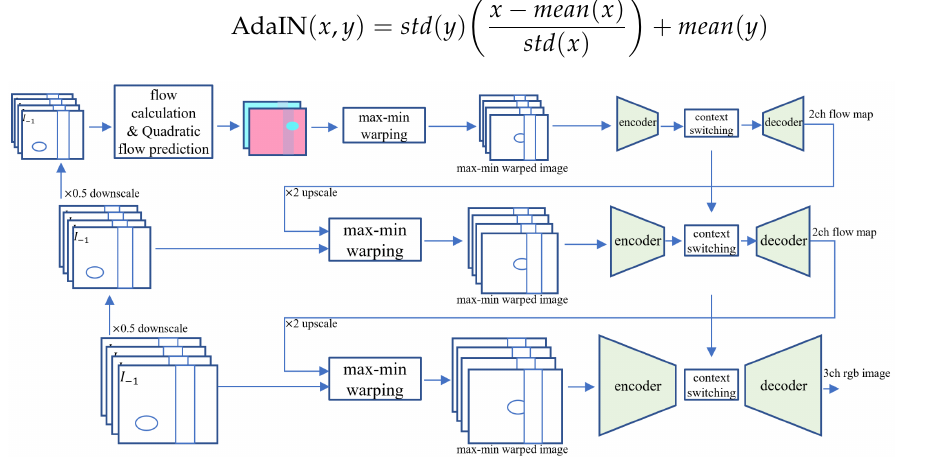
Figure 4. Proposed network overview.